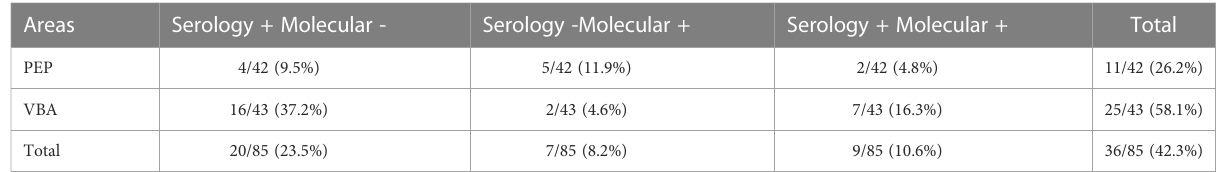
Areas Serology + Molecular -